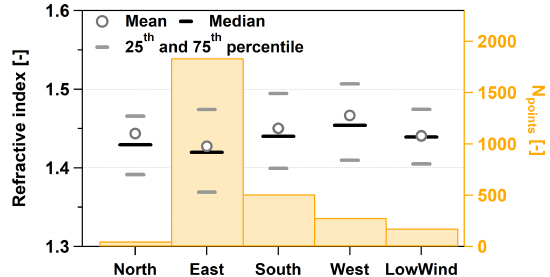
Figure 6. The averages, medians, and percentiles of the RI eff from coastal Antarctica separated by the wind direction, measured at λ = 633nm for dry aerosol particles. The orange bars refer to the right axis and show the number of successful RI